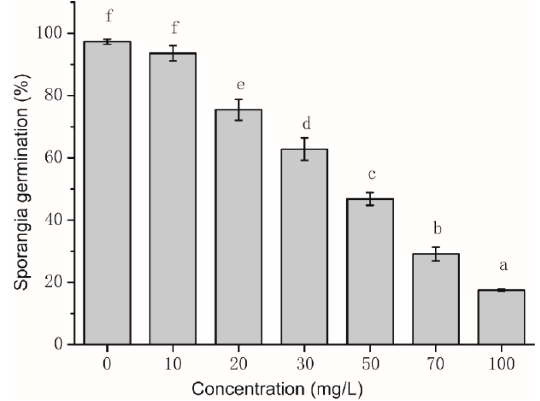
Figure 2. Inhibition effect of isoliquiritin against P. litchii Chen sporangia germination. Values were presented as mean ± S.E. Data presented were the means of pooled data ( n = 6). The column with different lowercase letters between different concentrations indicates significant differences according to Duncan Multiple Range Test ( p < 0.05).